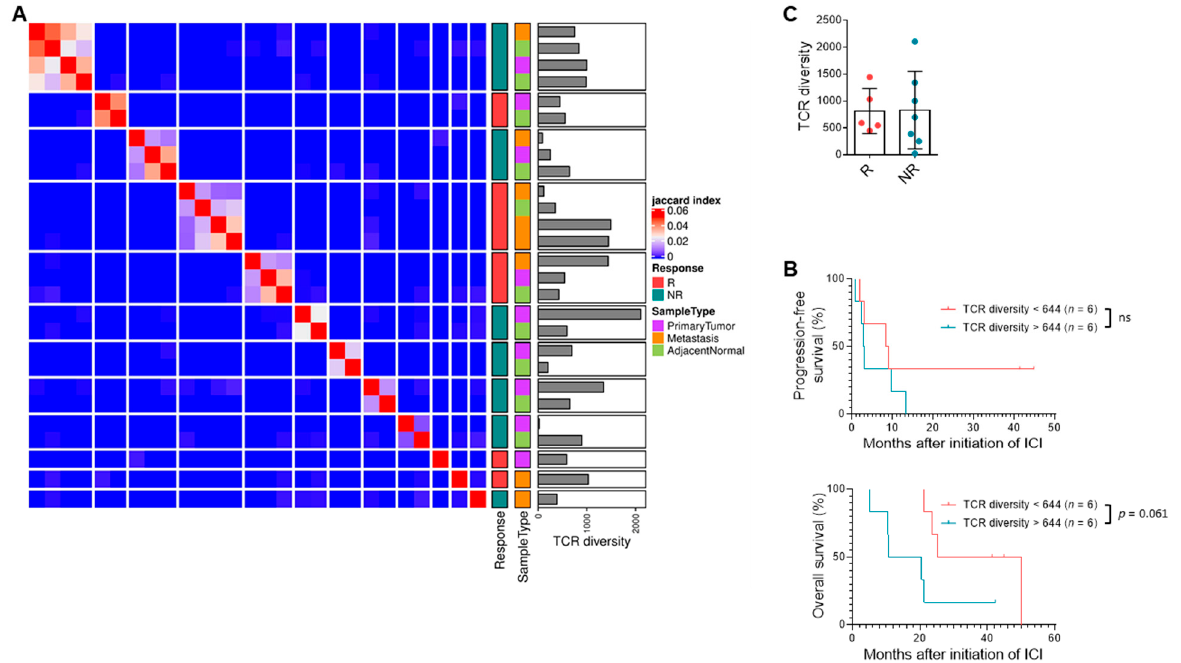
Figure 4. TCR clonal diversity does not correlate with response but may impact survival. ( A ) Heatmap depicting unsupervised clustering analysis of Jaccard index representing similarity among primary tumor, metastatic tumor, and adjacent normal samples from 12 patients in biomarker cohort based on TCR sequencing. ( B ) PFS and OS of patients with low versus high intra-tumoral TCR diversity based on median cutoff of 644 clonotypes. Log-rank test ( n = 6, 6). ( C ) Quantification of TCR diversity in primary tumors from responders compared to non-responders. Data shown are averages ± SD.